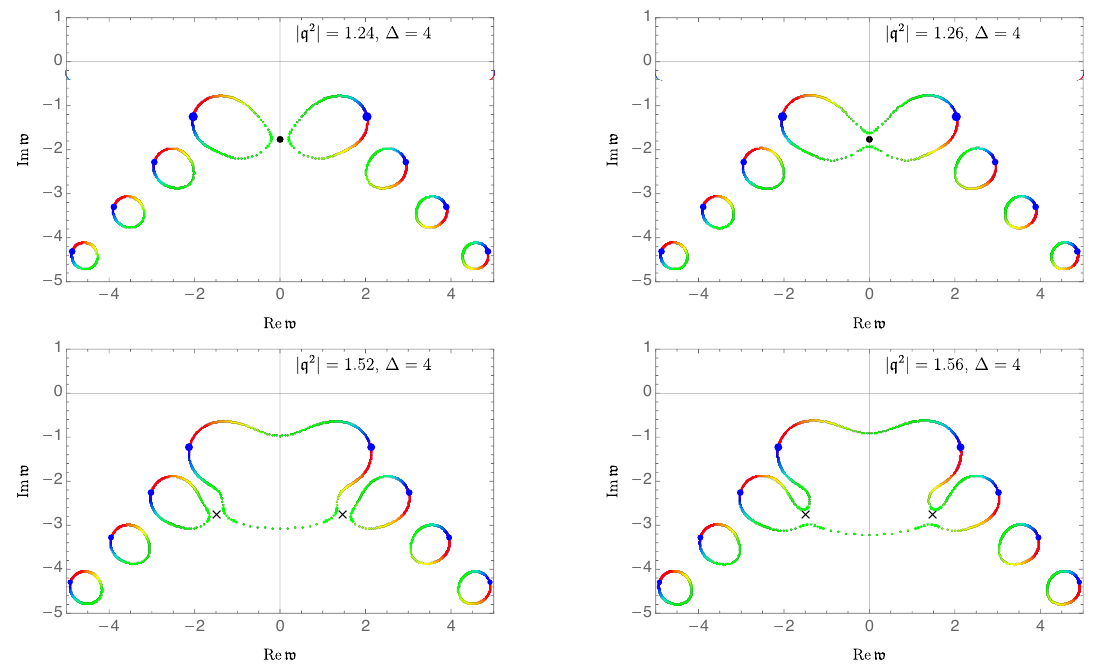
Figure 5 . Lowest-level-degeneracy. Poles of the retarded two-point function of the scalar operator, in the complex w − plane, at various values of the complexified momentum q 2 = | q 2 | e iθ . Blue dots correspond to the location of poles for real q 2 , namely for θ = 0 . As θ increases from 0 to 2 π , each pole moves counter-clockwise following the trajectory whose color changes continuously from blue to red. The two top panels show the situation slightly before and after the collision point marked by black dots. At the critical value | q 2 | ≈ 1 . 25 , the trajectories of the lowest-lying modes collide. After c the collision, the orbits of these modes are no longer closed: the two of them exchange their positions as the phase θ increases from 0 to 2 π . The second collision occurs at a higher momentum. The two bottom panels show the situation slightly before and after the second collision, marked by black crosses. At the critical value | q 2 | ≈ 1 . 54 , the trajectories of the second QNMs collide with the com- c mon trajectory of the lowest-lying modes. After the collision, the two lowest-lying modes together with the second QNMs exchange their positions cyclically as the phase θ increase from 0 to 2 π